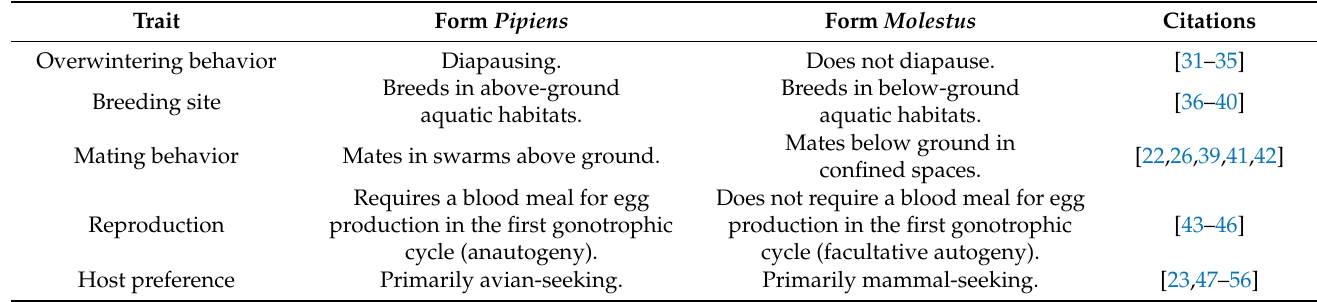
Table 1. Differences in behavioral and physiological traits for the pipiens and molestus bioforms of the northern house mosquito, Culex pipiens . Trait Form Pipiens Form Molestus Overwintering behavior Breeding site Mating